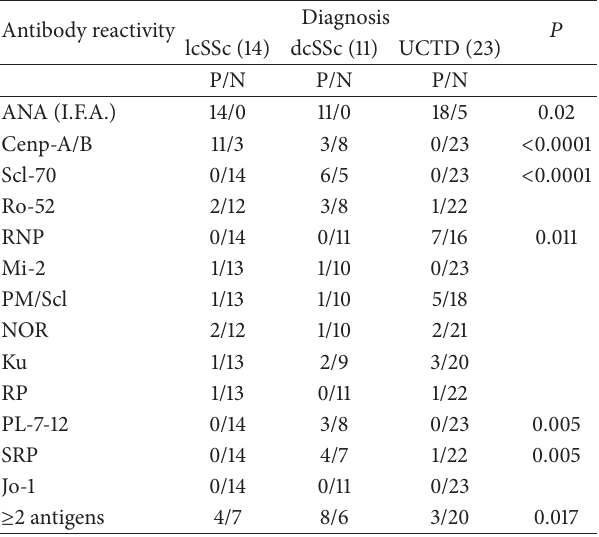
Table3:Frequencyofreactivitytonuclear,nucleolar,orcytoplasmic antigens. Antibody